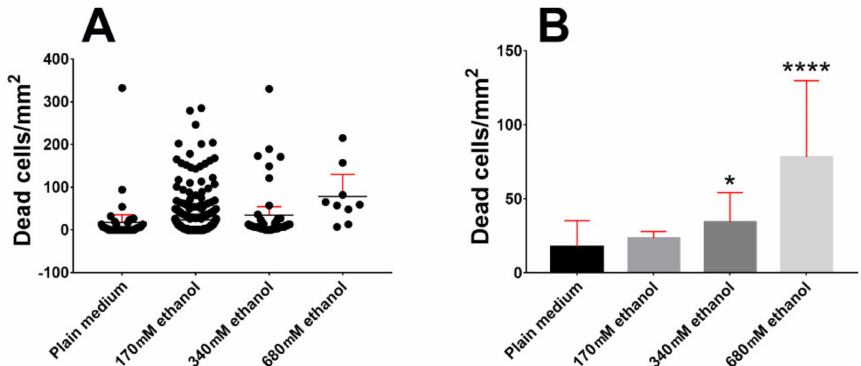
Figure 2. Descriptive exploratory statistics ( A ) and inferential statistics ( B ) of the e ff ects of di ff erent ethanol concentrations in culture medium onto cerebellar naturally occurring neuronal death (NOND). Dead cells were stained with propidium iodide and results are expressed as means of dead cells / area. Two-tailed Kruskal–Wallis test and Dunn’s multiple comparison test (plain medium vs ethanolic media) were applied, as data did not pass the D’Agostino and Pearson normality test. * 0.05 > p > 0.01, **** p < 0.0001. Bars are 95% CI.